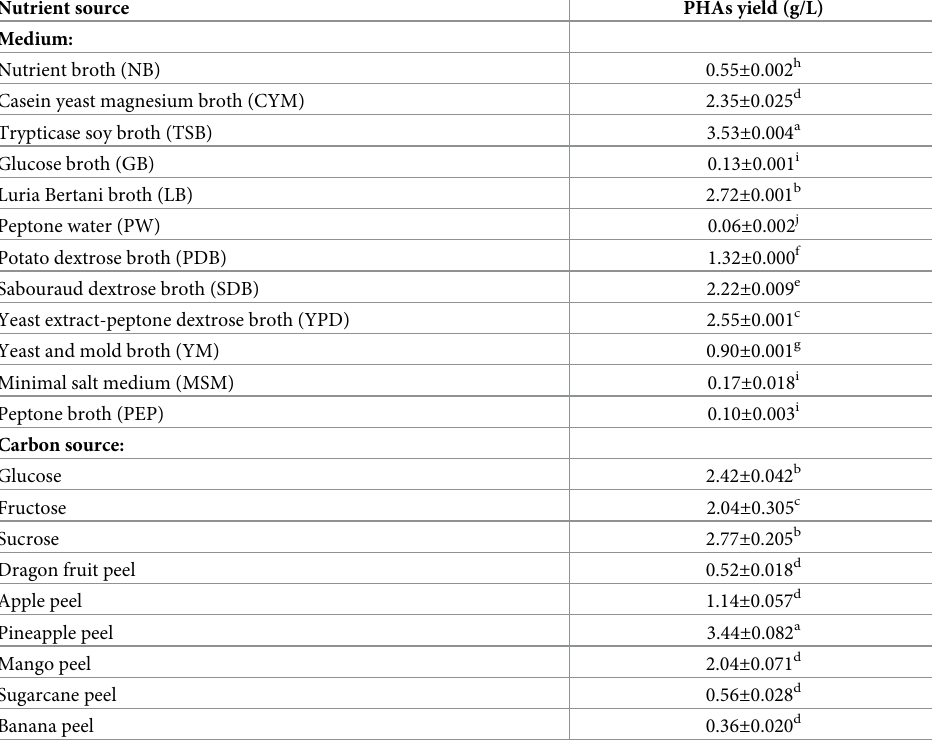
Table 2. Effect of various media and carbon sources on PHAs production by Bacillus drentensis BP17 after 72 h at 30˚C under shaking (150 rpm).